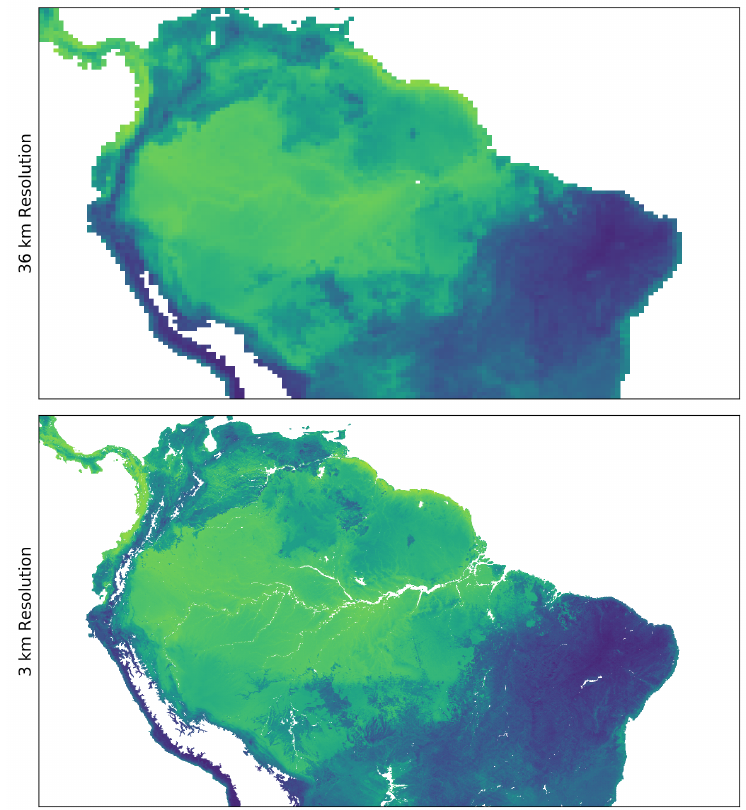
Figure 16. Comparison of the 36 km resolution (matching UCAR) to the 3 km resolution achievable with the CNN-based approach. White regions are those filtered due to surface water or topography